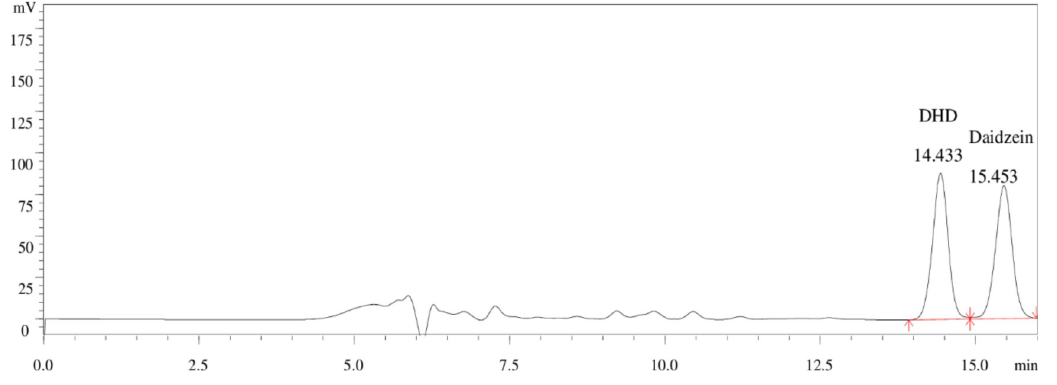
Fig 1. HPLC chromatogram of standards for daidzein and